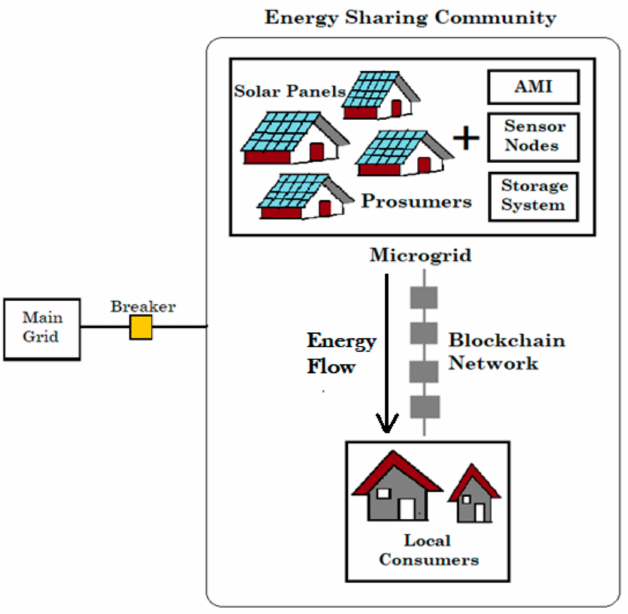
Figure 4. A smart energy community model. AMI: advanced metering